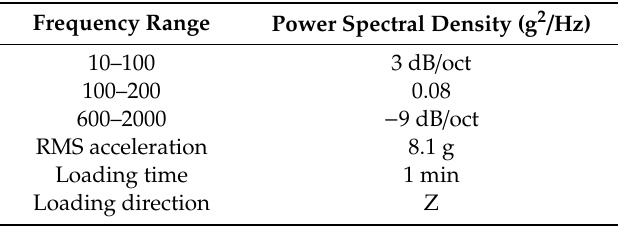
Table 2. Random excitation loading conditions.